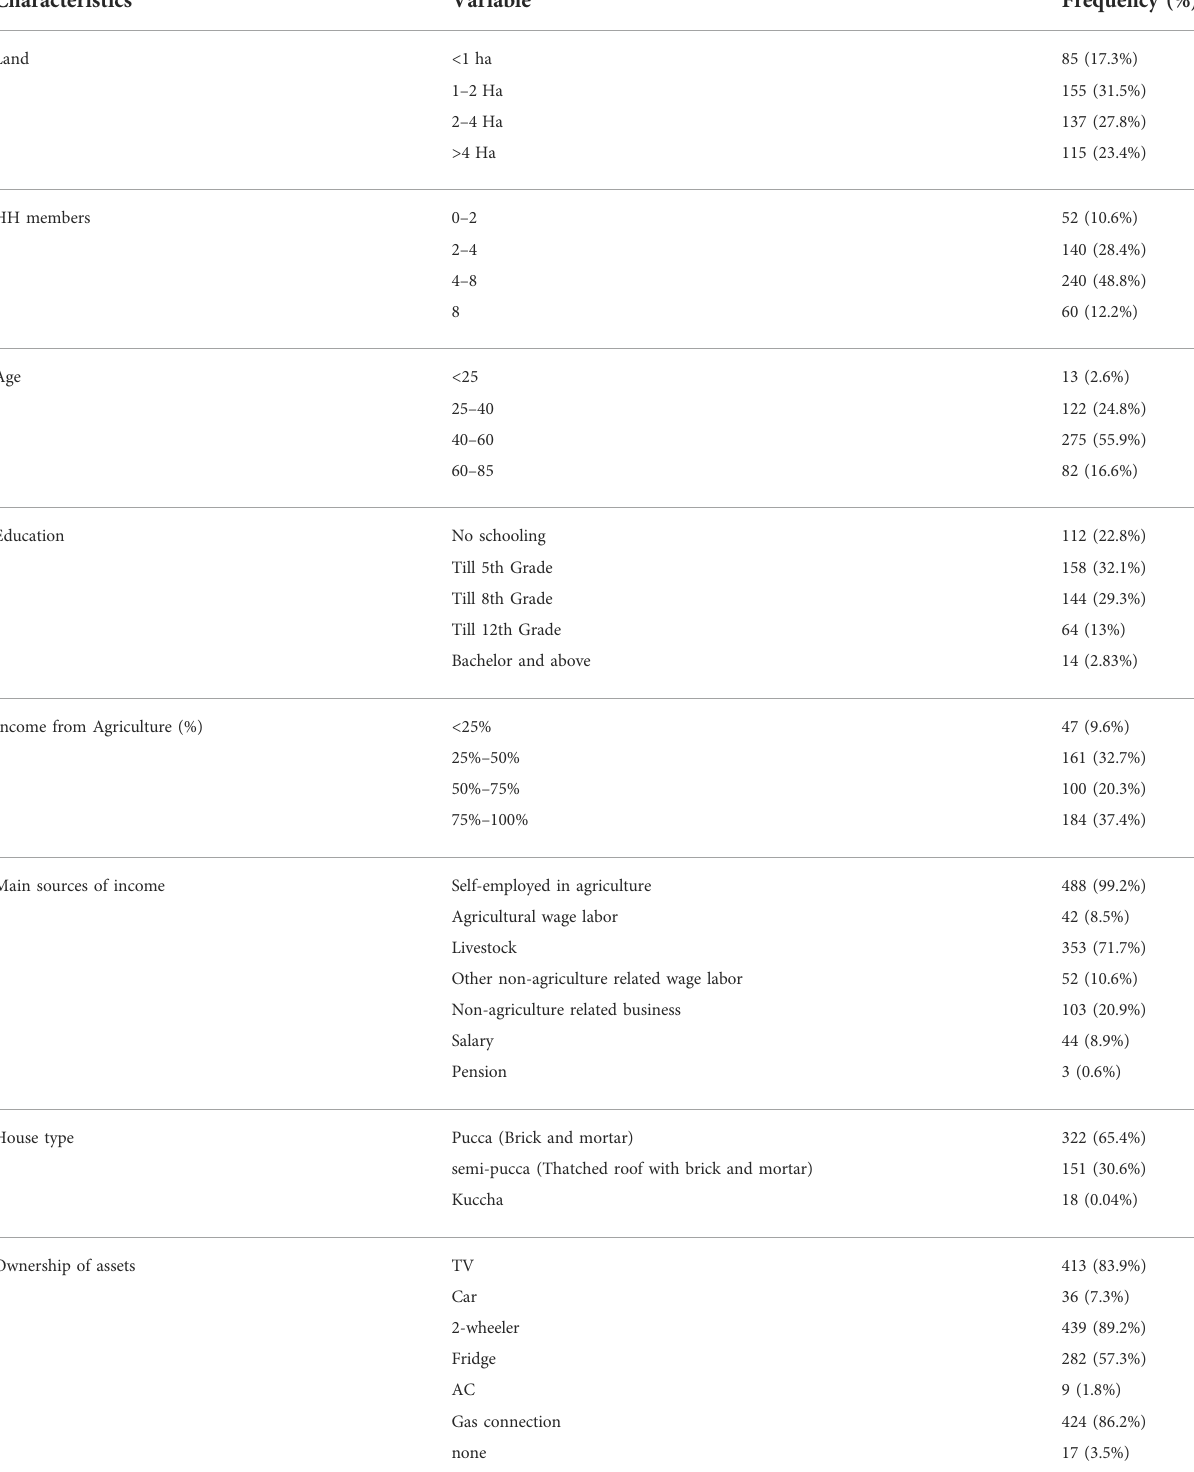
TABLE 2 Socio-economic characteristics of